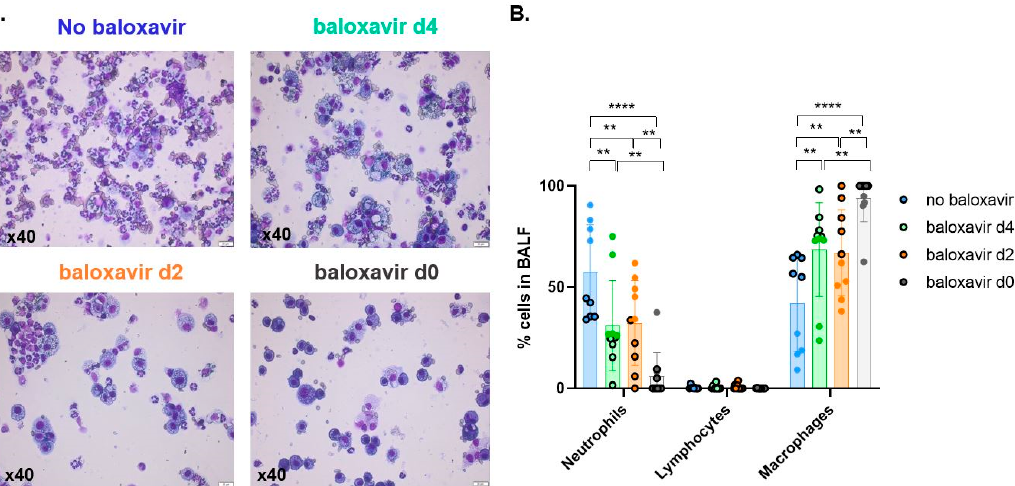
Figure 6. Treatment onset-dependent reduction in local immune response. ( A , B ) Visualization ( A ) and quantification ( B ) of mono- and polymorphonuclear leukocyte populations in bronchoalveolar lavage fluid from non-treated (no baloxavir, blue, n = 10 mice), baloxavir marboxil from day 4 (green, n = 10 mice), baloxavir marboxil from day 2 (orange, n = 10 mice) and baloxavir marboxil from day 0 (grey, n = 10 mice). Color fill vs. black contour color filled dot represents results from two different experiments. ** p < 0.01, **** p < 0.0001. Graphs are represented individual data points, mean ± SD.